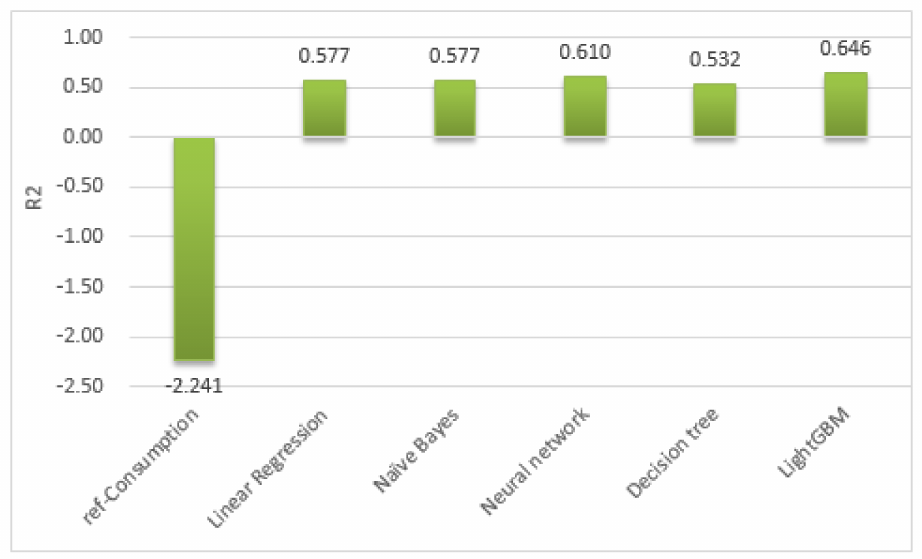
Figure 5. R 2 of different models.